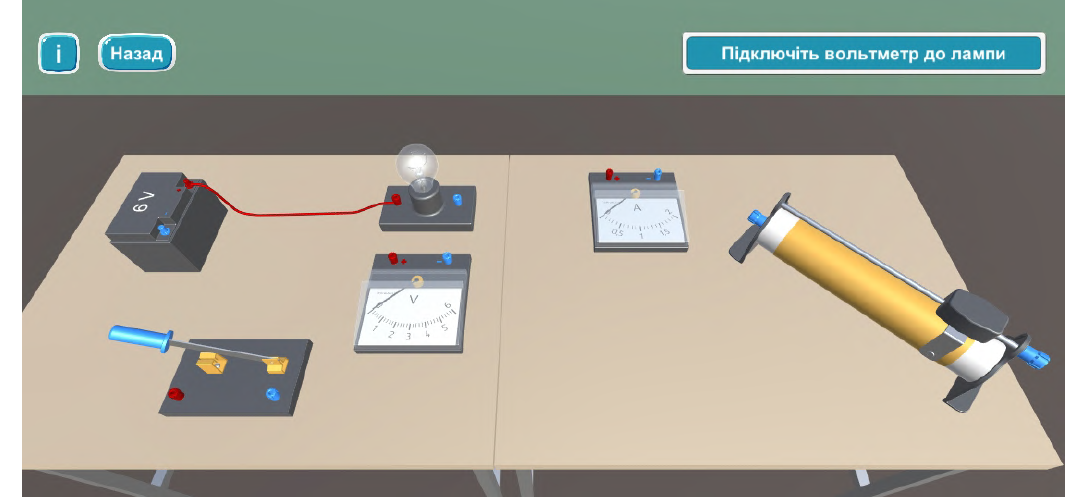
Figure 12: Operation of the practical training scene.